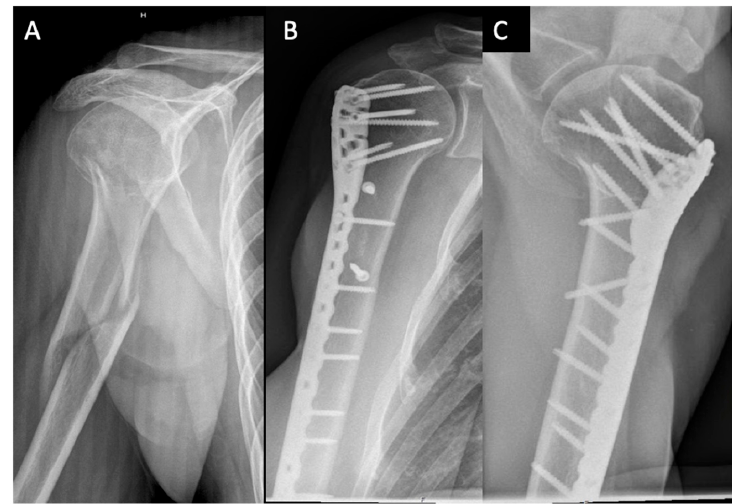
Figure 4. Example of surgical treatment with plating: ( A ) Anterior–posterior X-ray image of an extended D2 fracture of a 50-year-old woman according to the Stedtfeld classification. ( B ) Anterior– posterior X-ray image 16 months postoperative after treatment by plate osteosynthesis and additive metaphyseal screw stabilization. ( C ) Axial X-ray image 16 months postoperative after treatment by plate osteosynthesis and additive metaphyseal screw stabilization.